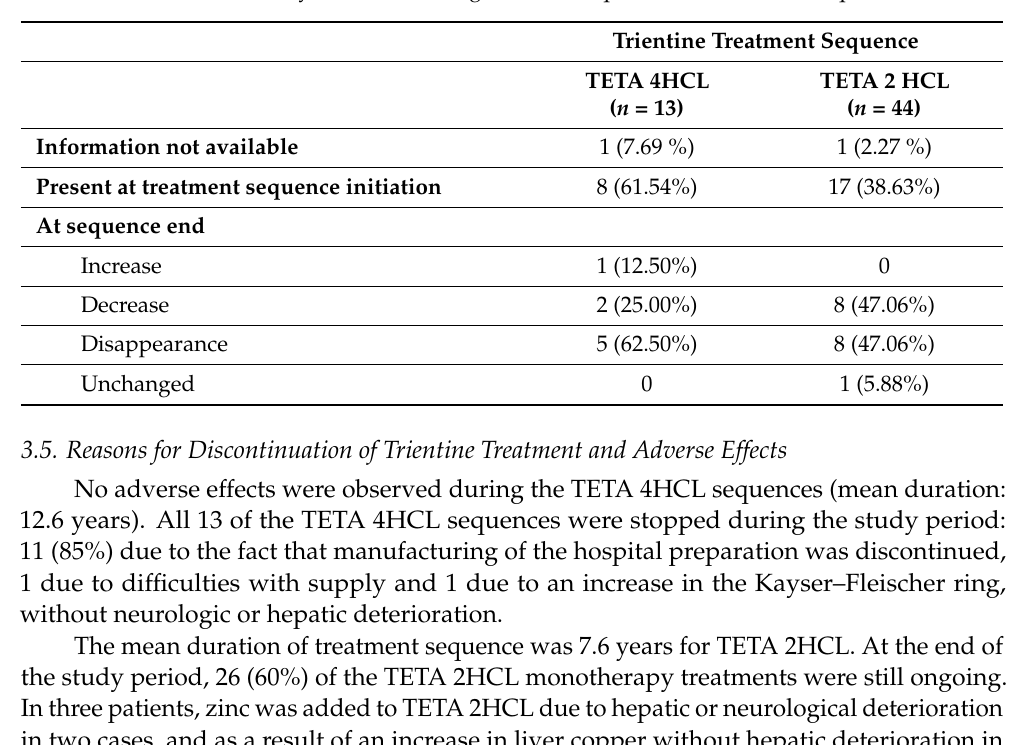
Table 4. Evolution of the Kayser-Fleischer ring between sequence initiation and sequence